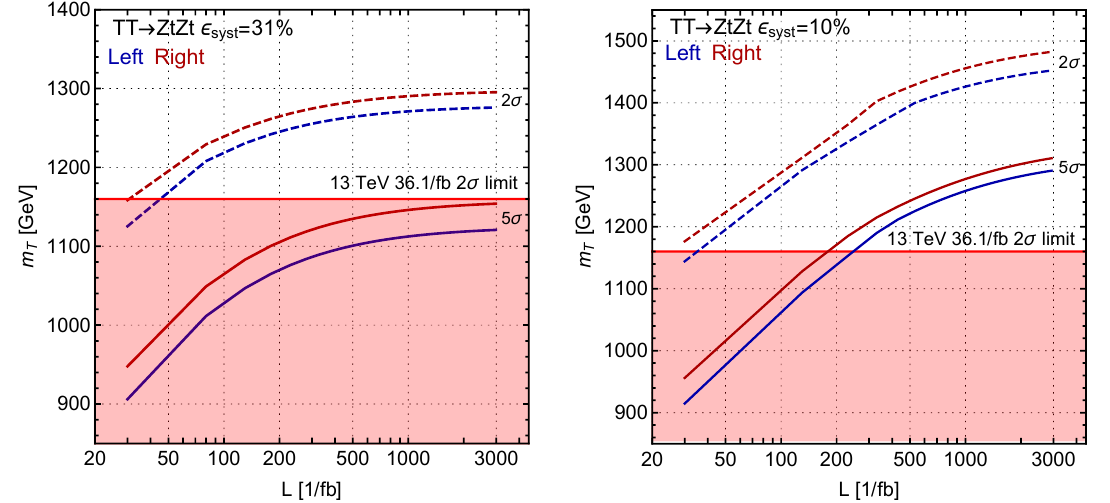
Figure 4 . Projected exclusion (dashed) and discovery (solid) reach of the ATLAS single lepton search [25] for a T VLQ decaying with 100% branching ratio in Zt . The blue and red lines correspond to a left- and right-handed chiral coupling. The left and the right plots correspond to assuming an uncertainty on the background determination of 31% and 10% respectively. The red shaded area correspond to the present observed limit for a VLQ decaying with 100% branching ratio into the Zt (cid:12)nal state, namely 1160 GeV [25] the left-handed and right-handed coupling case respectively. Such bounds are within (cid:24)